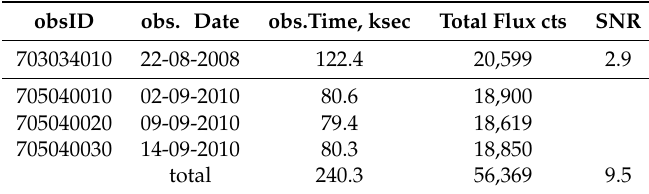
Table A3. Suzaku/XIS observations